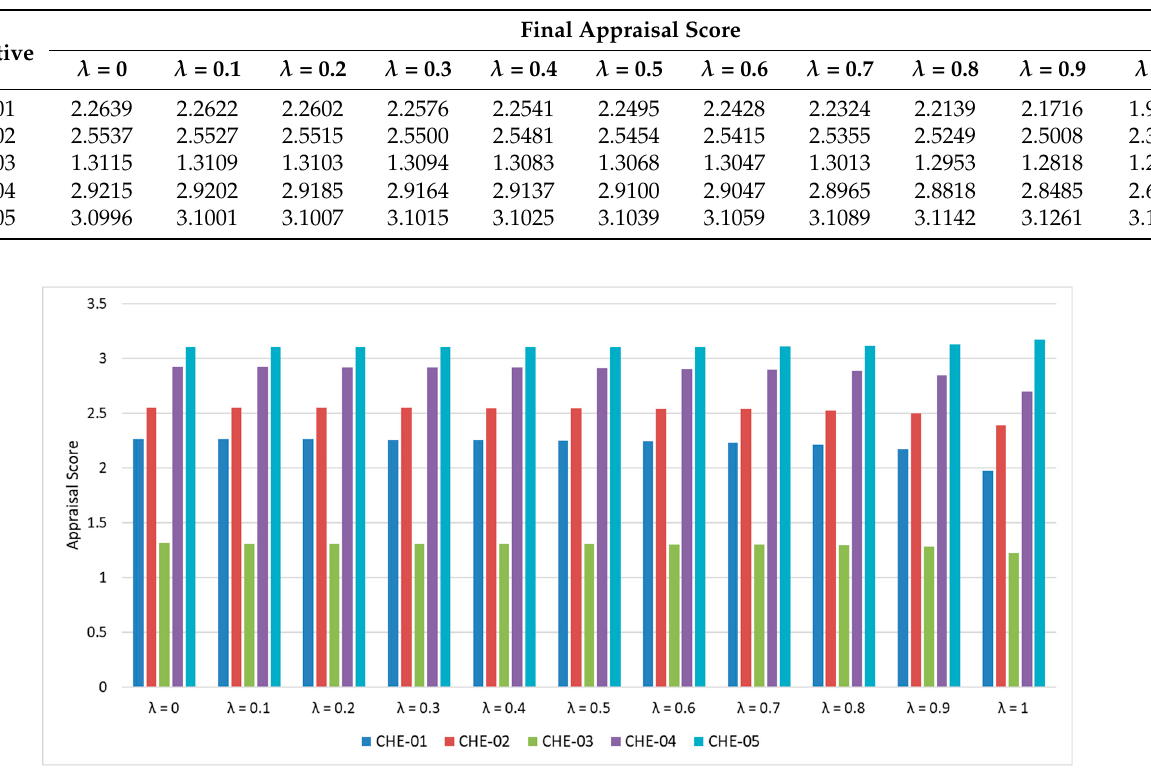
Figure 5. Sensitivity analysis with different 𝜆 values.